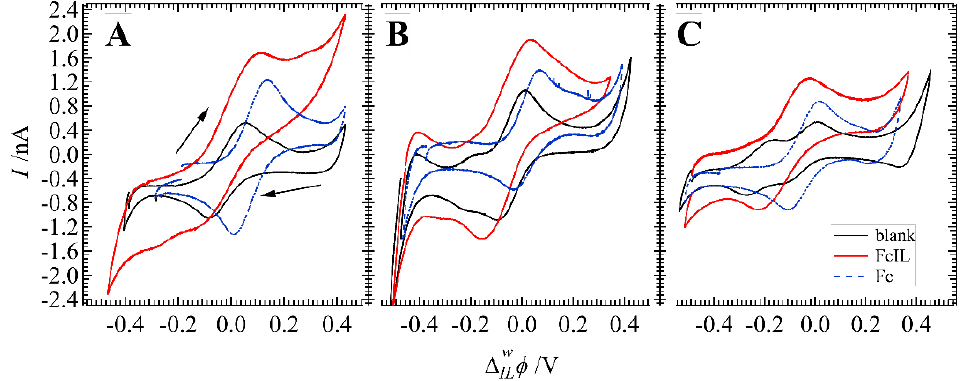
Figure 6. CVs acquired at a 25 µm diameter ITIES between w|P 8888 TB at ~60 °C and 0.020 V s – 1 using Cells 1b – 3b ( A – C ) with 1 mM KAuCl 4 (aq) and 100 mM of Fc (blue, dashed trace) or FcIL (red, solid curve) added to the P 8888 TB phase, as shown inset. Black traces depict CVs obtained without an electron donor added to P 8888 TB. Table 1. Data obtained from electron transfer waves depicted in Figures 6 and 7, including the for- ward ( E p,fwd ) and reverse ( E p,rev ) peak potentials, the peak-to-peak separation ( Δ E ), and the electron ( ) w as well as the peak current ( i transfer half-wave potential p ) and total charge trans- 1/2,ET o ferred (Q) as obtained for the forward wave.